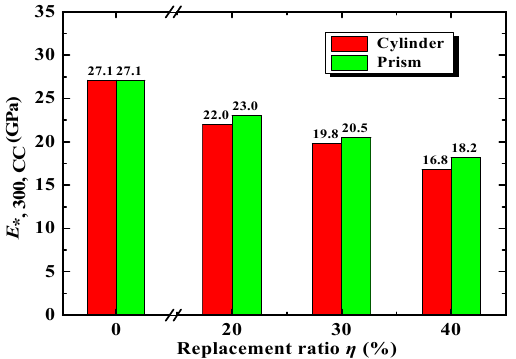
Figure 10. Shape effect on combined elastic modulus of prisms and cylinders made of DCLs and FC.